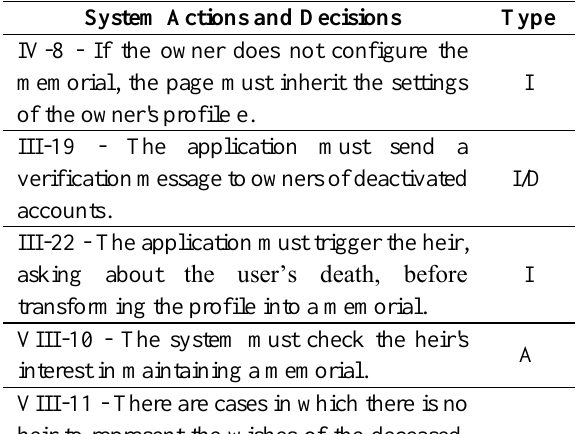
Table 6. System Actions and Decisions System Actions and